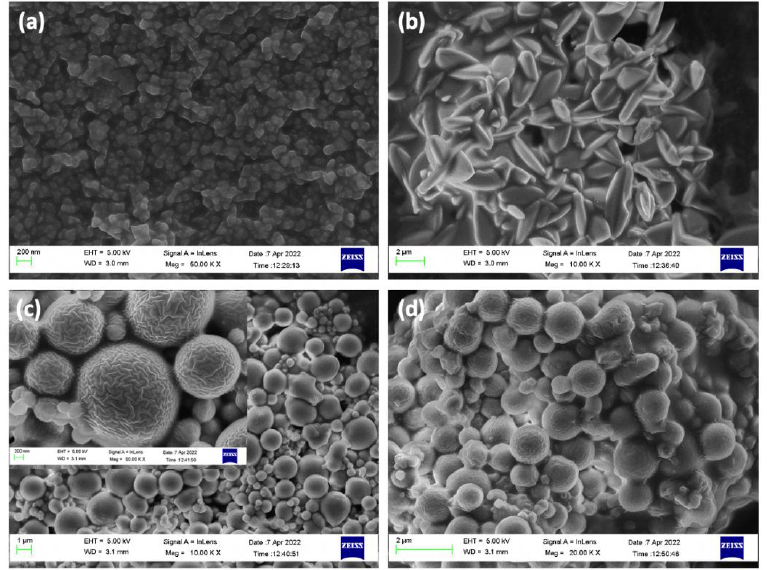
Figure 7. SEM images of ( a ) ZIF-8 (5 min, synthesis in water); ( b ) ZIF-8 (24 h, synthesis in water); ( c ) ZIF-8 (5 min, synthesis in acetone); and ( d ) ZIF-8 (24 h, synthesis in acetone).